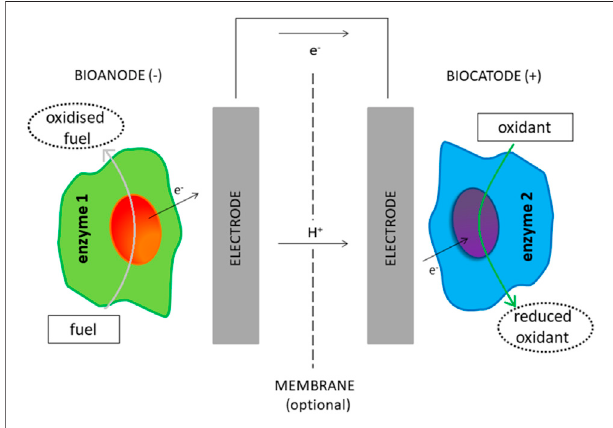
FIGURE 1 | Schematic representation of enzymatic biofuel cells (Barelli et al., 2021).